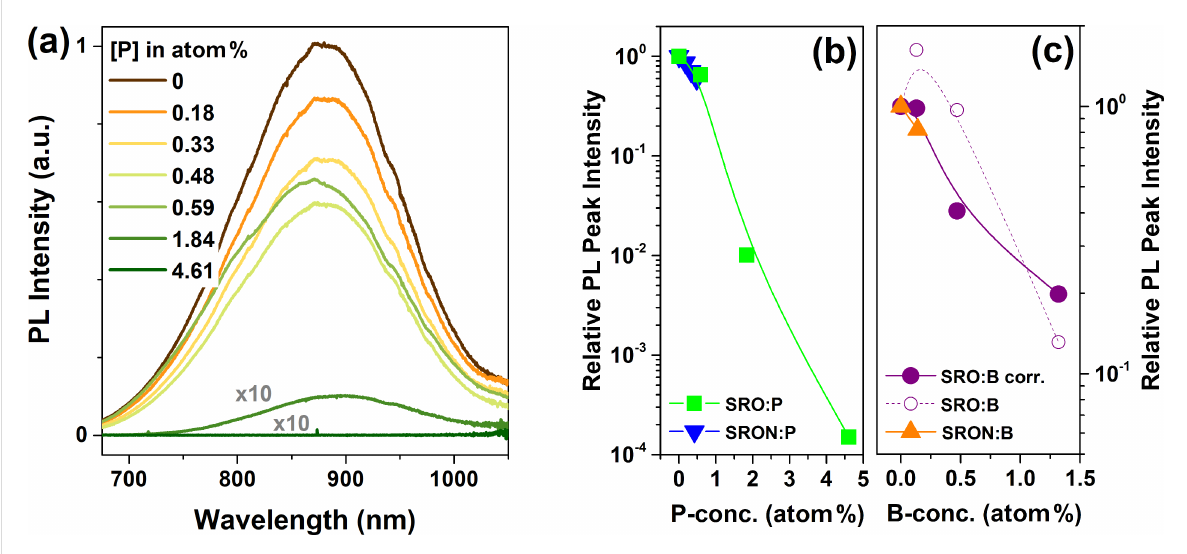
Figure 3: (a) Room temperature photoluminescence spectra of P-incorporating Si NCs in SRON (0–0.48 atom %) and SRO (0.59–4.61 atom %). The spectra of the two highest P-concentrations are multiplied by a factor of 10 for better visibility. (b) and (c) logarithmic PL peak intensity as function of P-concentration, or respectively B-concentration, in SRO and SRON, normalized to the respective dopant-free samples. For SRO:B-samples the PL-intensities are corrected for the excess-Si content (open purple circles show the raw data). Lines are just a guide to the eye. For both dopants it is obvious that significant PL-quenching requires P-/B-concentrations >1 atom